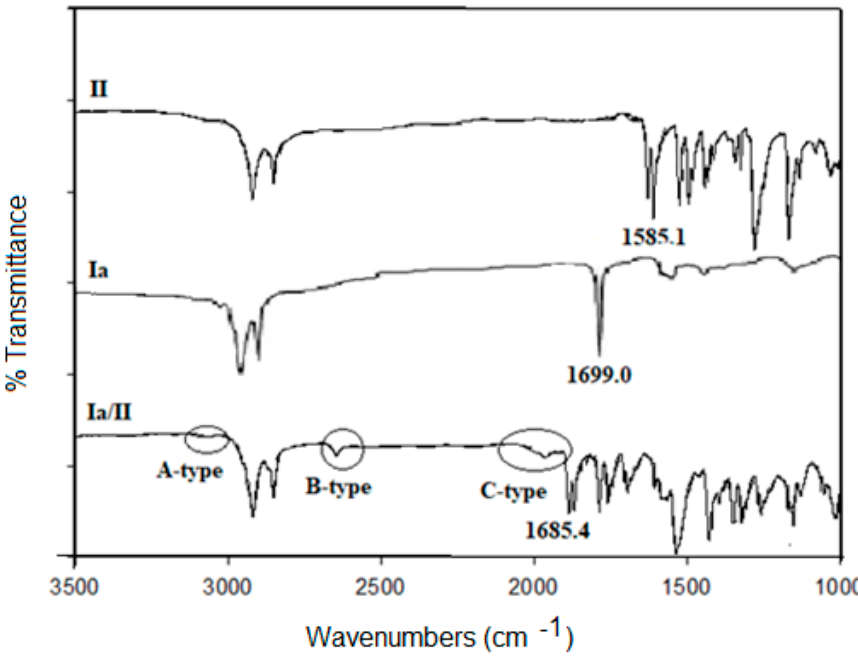
Figure 2. Collective FT-IR spectra of Ia, II, and their complex Ia/II .